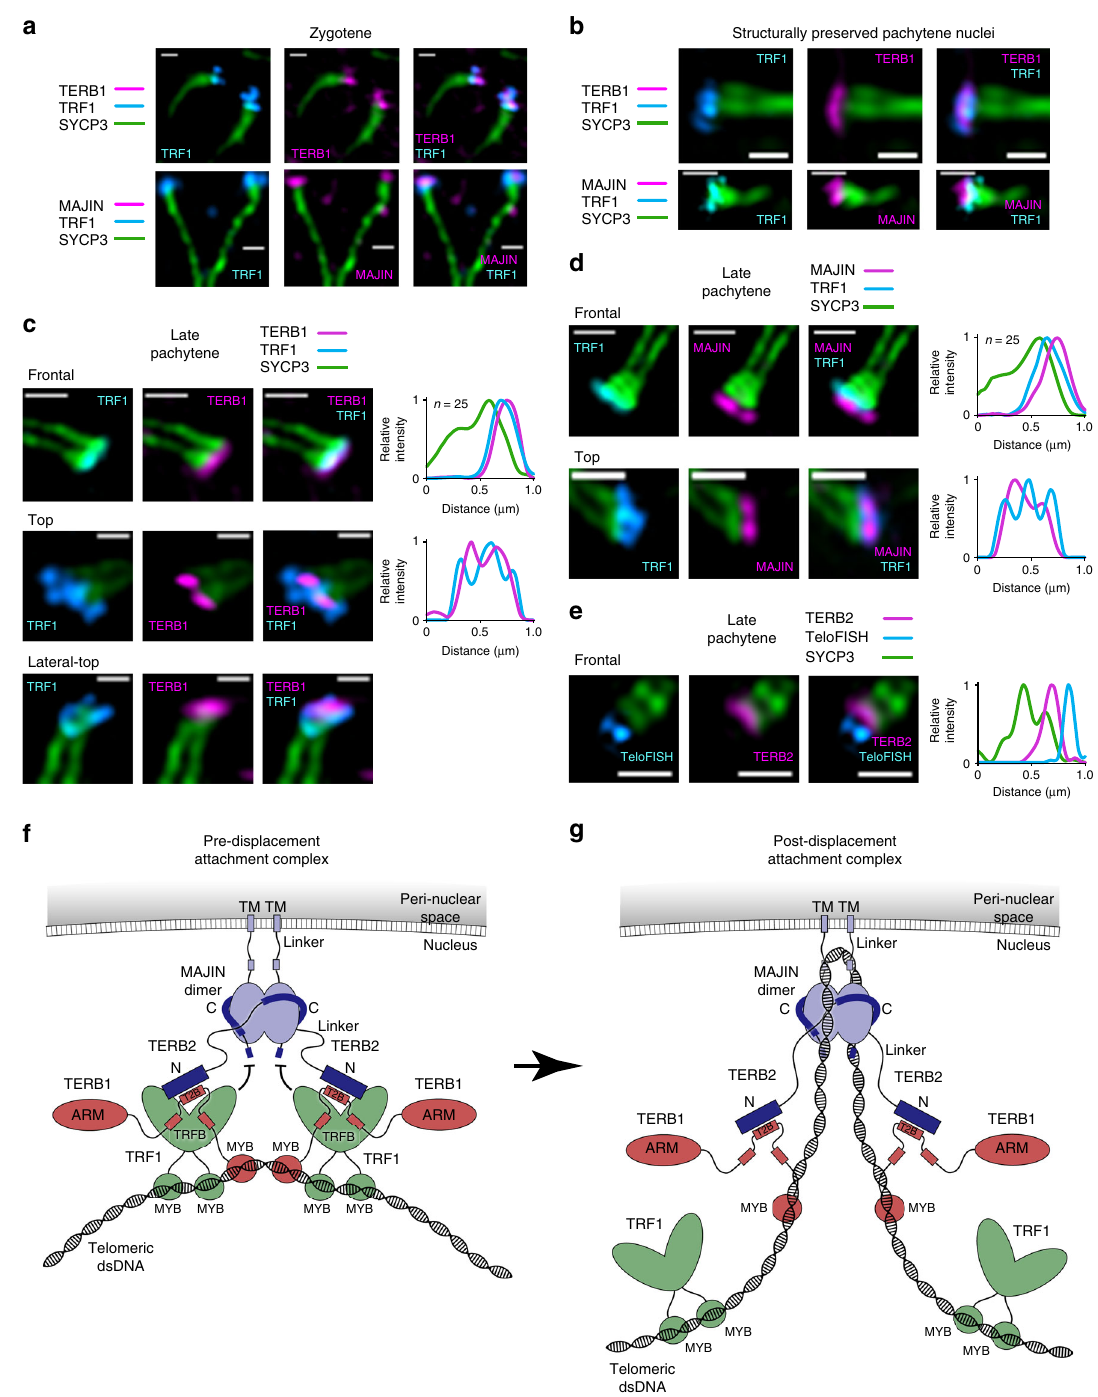
Fig. 8 TRF1-mediated chromosomal attachment to the meiotic telomere complex. a – e Structured illumination microscopy. Wide- fi eld images, plot analyses and additional orientations are shown in Supplementary Figs. 14 and 15. a Spread mouse zygotene spermatocyte chromosomes stained with anti-SYCP3 (green), anti-TRF1 (cyan) and anti-TERB1 (top) or anti-MAJIN (bottom) (magenta). Scale bars, 0.3 µ m. b Structurally preserved mouse spermatocyte pachytene nuclei stained with anti-SYCP3 (green), anti-TRF1 (cyan) and anti-TERB1 (top) or anti-MAJIN (bottom) (magenta). Scale bars, 0.3 µ m. c – e Spread mouse pachytene spermatocyte chromosomes stained with anti-SYCP3 (green) and ( c ) anti-TERB1 (magenta) and anti-TRF1 (cyan), ( d ) anti- MAJIN (magenta) and anti-TRF1 (cyan), and ( e ) anti-TERB2 (magenta) in combination with telomere fl uorescence in situ hybridisation (cyan; TeloFISH). Scale bars, 0.3 µ m and 0.5 µ m. Normalised intensity-distance plots are shown; frontal plots represent averages of multiple images (n = 25 telomeres), other orientation plots represent individual images. Source data are provided as a Source Data fi le. f , g Model of meiotic telomere attachment to the nuclear envelope. f Telomere ends are initially recruited through TRF1, which interacts with the meiotic telomere complex via TERB1, mediating its indirect interaction with telomeres. g TRF1 is subsequently displaced, allowing the meiotic telomere complex to bind directly to telomeric DNA, with TRF1 associating with surrounding telomeric DNA. Source